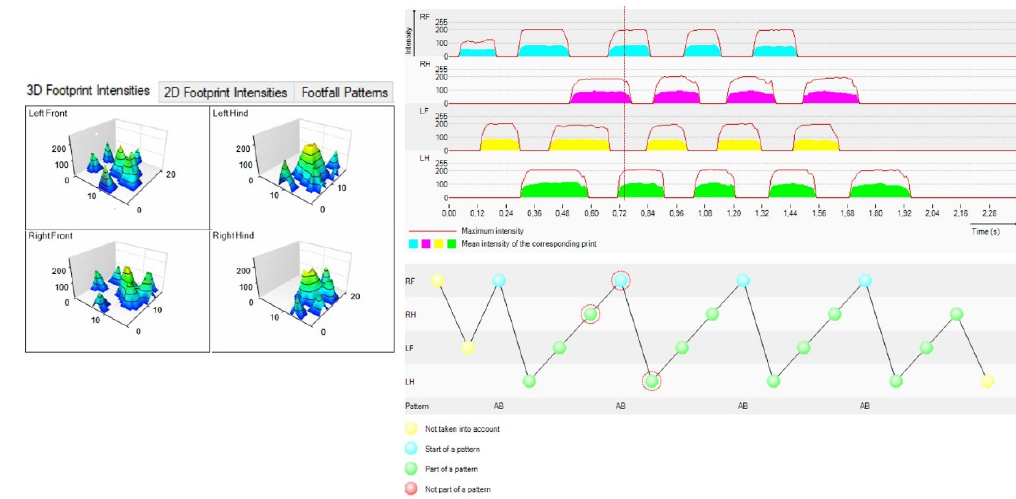
Figure 4. The 3D representations of all four paws in a Wistar rat registered using the CW system in normal speed passing. Left panel depicts 3D registration of each of the four paws. Right panel depicts the intensity of the print and the time periods for this intensity is sustained.